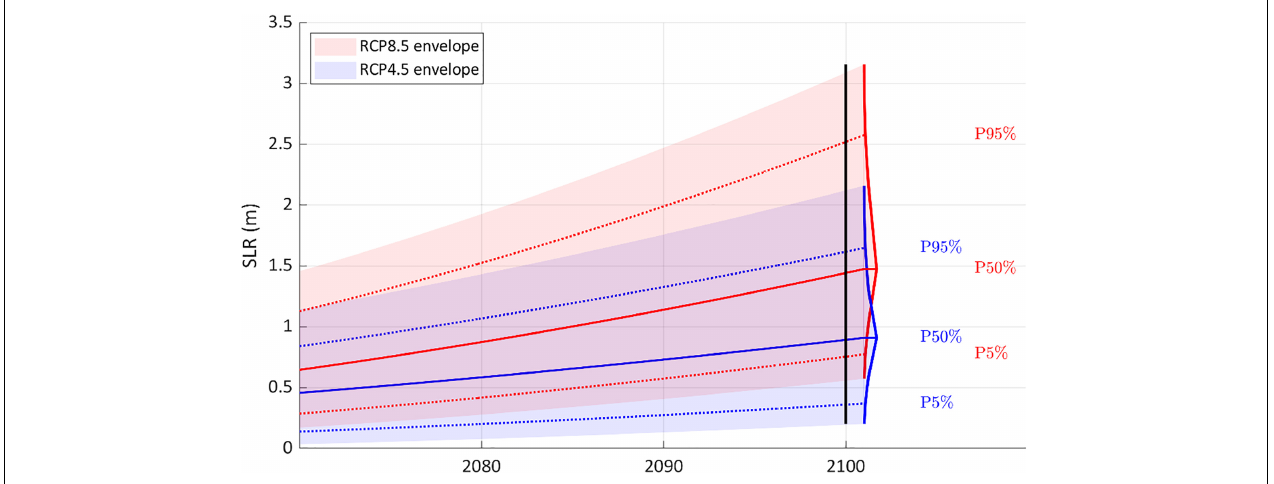
FIGURE 2 | Probabilistic projections of local-mean sea-level rise at Gijon tide-gauge for RCP4.5 and RCP8.5 from 2070 to 2100 using Kopp et al. (2017) framework. Solid lines indicate 50th percentile; dashed lines indicate 5 and 95th percentiles; shaded areas represent the 0.5 and 99.5th percentiles of the SLR distribution for